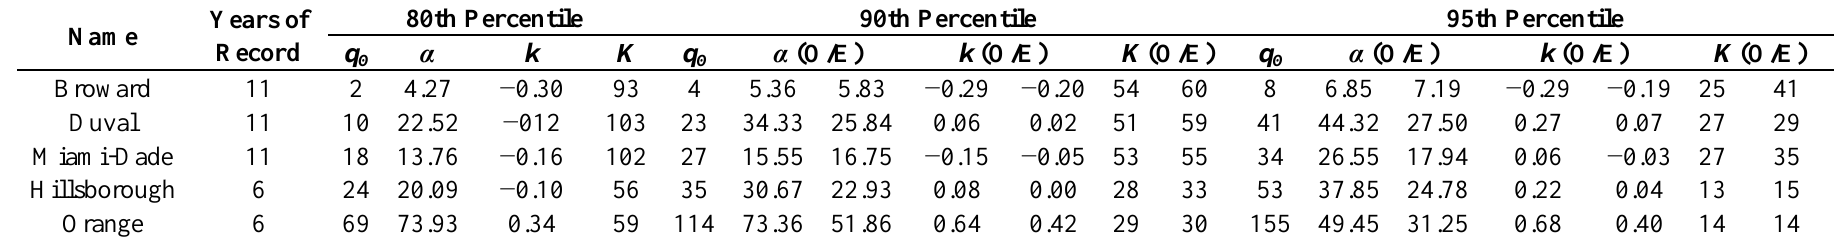
Table 2. Observed and expected parameters of magnitudes upon raising the thresholds to the 90th and 95th percentile levels (Definition 1). Note: q , the threshold; α , the scale parameter of GPD; k , the shape parameter of GPD; K , the total number of peak events in all flu years. 0